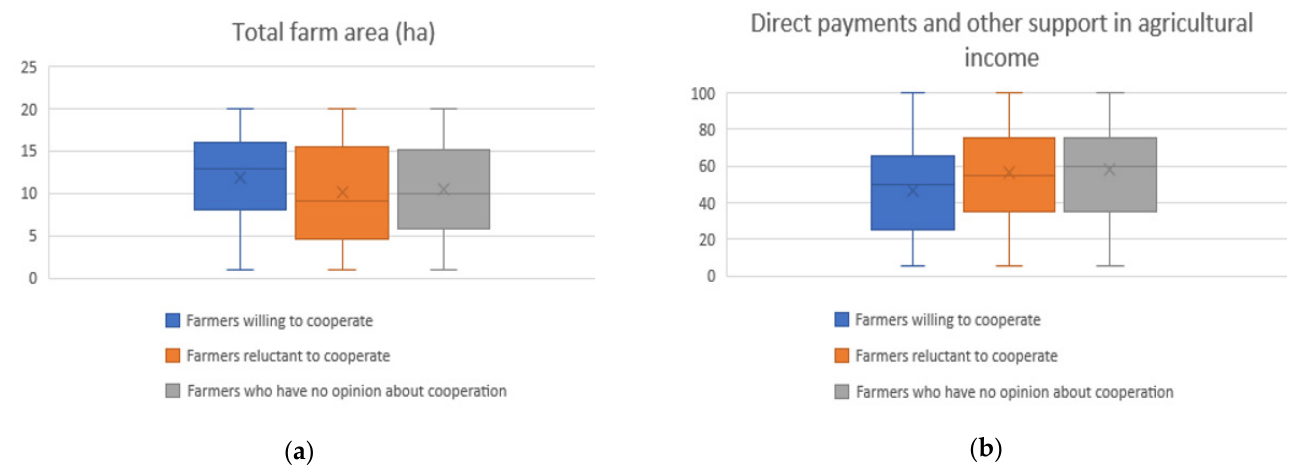
Figure 8. Small-scale farm physical size in ha ( a ) and dependency of farm on agricultural support ( b ) (N = 1002).